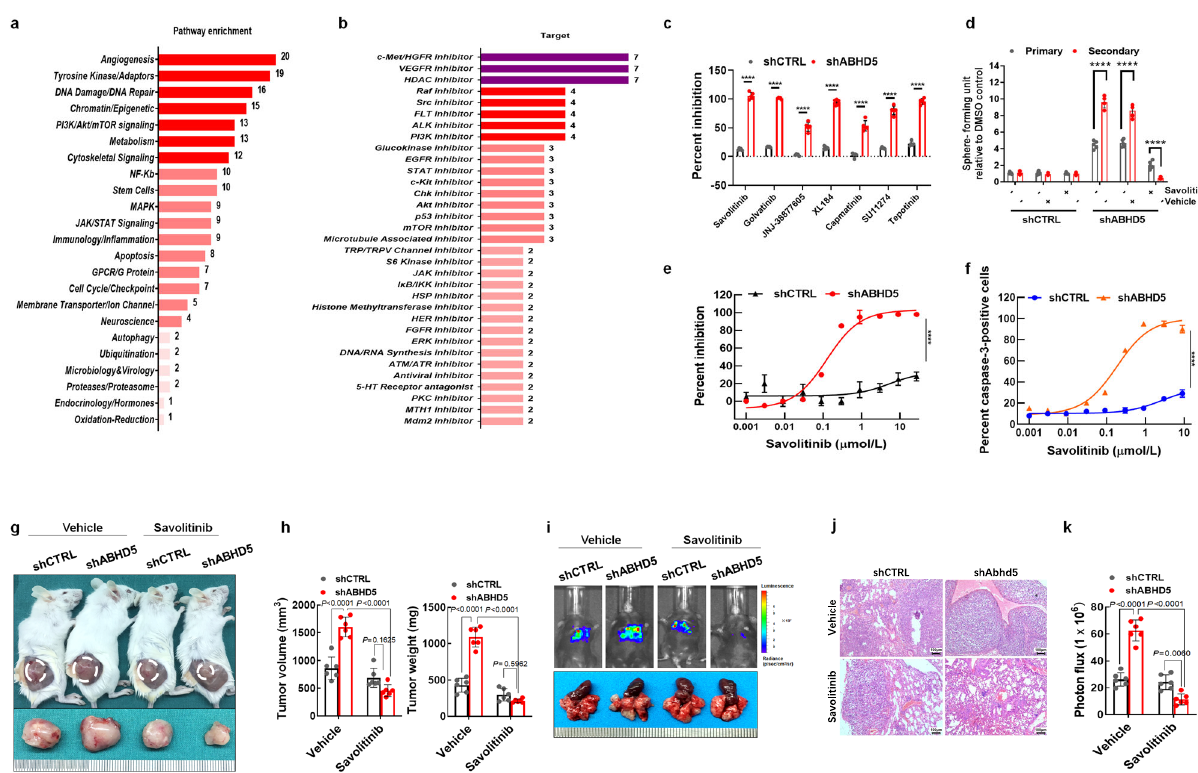
Fig. 2 c-Met inhibition is synthetic lethal with ABHD5 loss. a , b Pathway enrichment analysis ( a ) and target analysis ( b ) of the FDA-approved compounds that reduced cell viability (>90% viability) of ABHD5 -knockdown cells (>90%) with little to no effect on control cells. c The inhibitory rate analysis of shCTRL or shABHD5 HCT116 cells treated with FDA-approved c-Met inhibitors ( n = 5 biologically independent samples). d Sphere formation assay of HCT116 shCTRL or shABHD5 cells treated with 1 μ M savolitinib or vehicle control (DMSO) ( n = 5 biologically independent samples). e Savolitinib dose – response curves in HCT116 shCTRL or shABHD5 cells ( n = 5 biologically independent samples). f Caspase-3 activation in shCTRL or shABHD5 HCT116 cells treated with savolitinib from at least three independent experiments ( n = 5 biologically independent samples). g Subcutaneuos xenografts were established by shCTRL and shABHD5 HCT116 cells in NOD/SCID mice. The tumour-bearing mice were randomized into groups ( n = 6 mice/group) and dosed by oral gavage as follows: 10 ml/kg vehicle (acidic CMC-Na 0.5%, pH = 2.1) once daily or 2.5 mg/kg savolitinib once daily for 21 days. The representative images of the xenografts were shown. h Statistical analyses of the tumour volume and tumour weight in the indicated groups in ( g ) ( n = 6 mice/group). i Lung metastatic xenografts were established by shCTRL and shABHD5 HCT116 cells in NOD/SCID mice. The tumour-bearing mice were randomized into groups ( n = 6 mice/group) and dosed by oral gavage as follows: 10 ml/kg vehicle (acidic CMC-Na 0.5%, pH = 2.1) once daily or 2.5 mg/ kg savolitinib once daily for 21 days. The representative bioluminescent and gross images of lung metastases in NOD/SCID mice were shown. j The representative images of HE staining of lung tissues in NOD/SCID mice of ( i ). k The quanti fi cations of bioluminescent images of lung metastases in the indicated groups in ( i ) ( n = 6 mice/group) (Data are shown as mean ± s.e.m. Panels ( c − f ), ( h ) and ( k ) were analysed using two-way ANOVA and Sidak ’